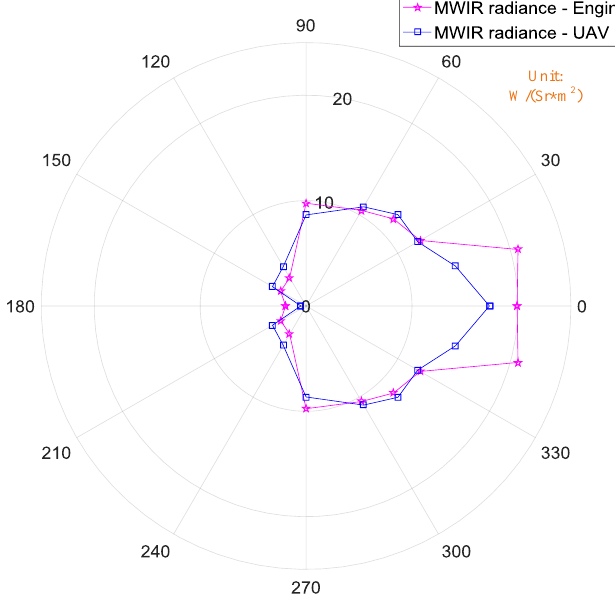
Figure 19. Comparison of MWIR radiance between engine and UAV.